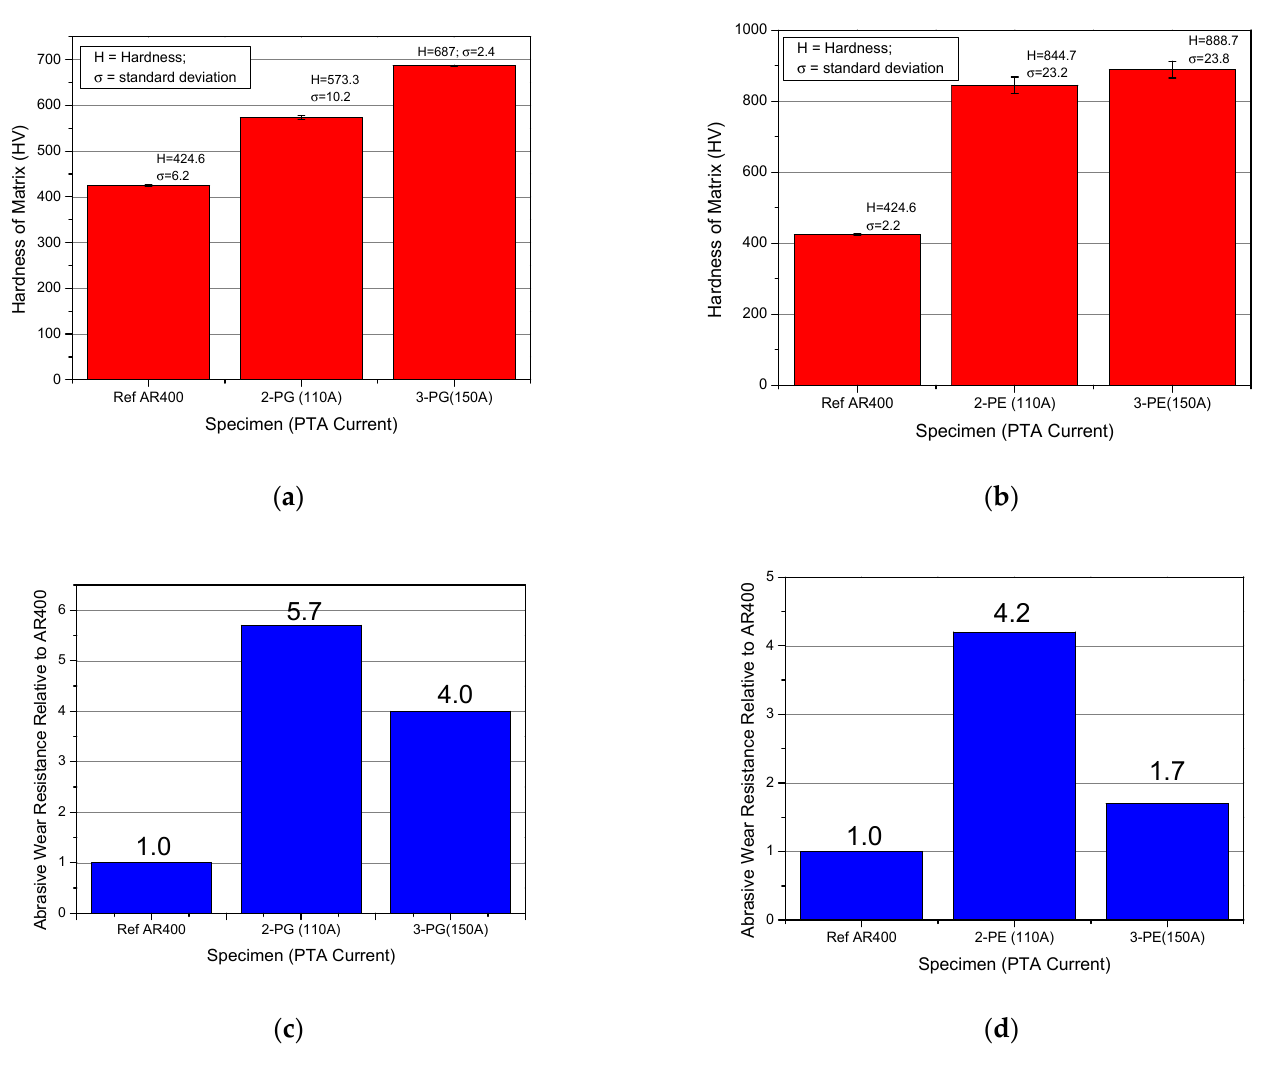
Figure 15. Comparative plots on the effects of PTA current on hardness and abrasive wear performance of surface coating ( a , b ) effects of PTA current on hardness of matrix of samples prepared with PG and PE powder MMCs respectively ( c , d ) effects of PTA current on the abrasive wear resistance of samples prepared with PG and PE powder MMCs